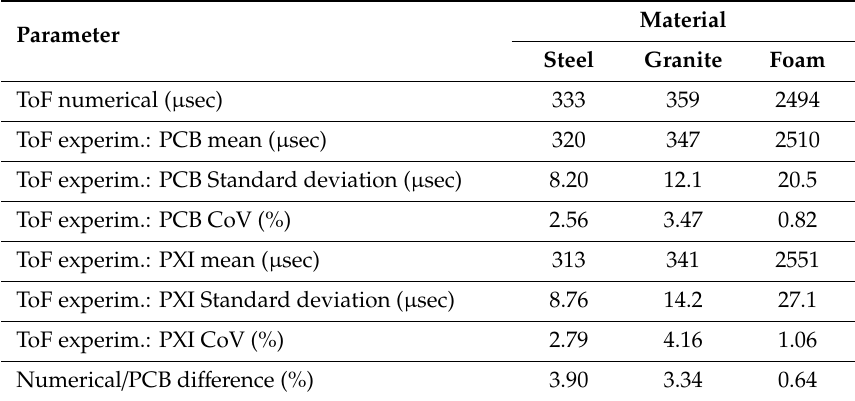
Table 2. Summary of the experimental and numerical results relative to the time-of-flight of the primary reflected solitary wave. The CoV represents the coe ffi cient of variation, i.e., the ration of the standard deviation to the mean